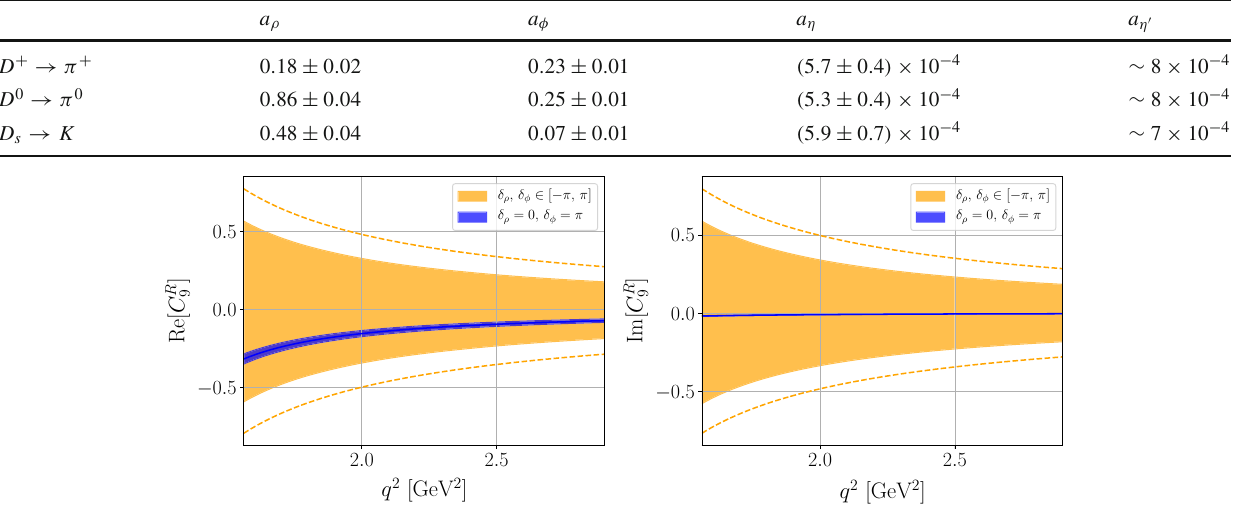
Table 1 Phenomenological resonance parameters (in GeV 2 ) extracted from the experimental measurements of B ( D → π M ) and B ( D s → K M ) with resonances M = ρ,φ,η,η (cid:3) decaying to μ + μ −